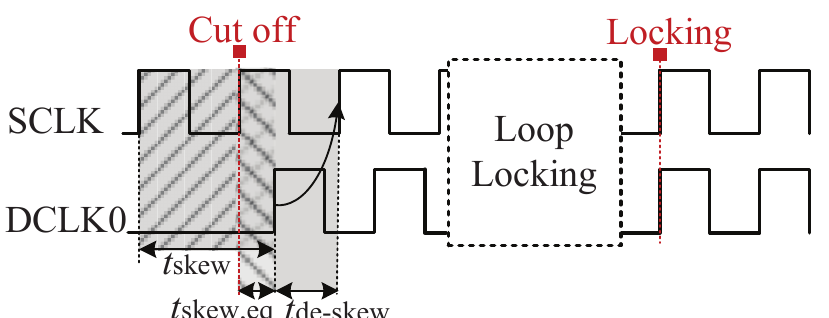
Figure 5. The relationship between the real skew and equivalent